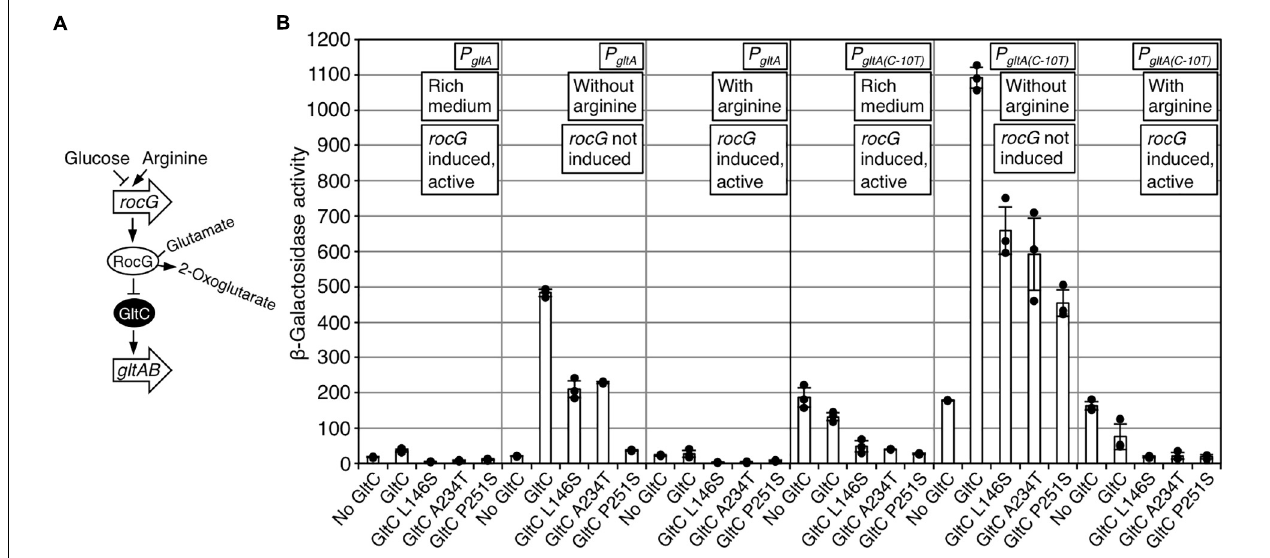
FIGURE 6 | (A) Control of DNA-binding activity of GltC by RocG. (B) Regulation of the P gltA wild type and the P gltA ( C − 10 T ) promoter in the strains GP650 ( P gltA -lacZ gltC − rocG + gudB − ) and GP692 ( P gltA ( C − 10 T ) -lacZ gltC − rocG + gudB − ), respectively, synthesizing the GltC variants L146S, A234T, and P251S variants with enhanced repressor function during growth in SP rich medium, CSE-Glc minimal medium without and with arginine. Isogenic strains carrying the plasmids pBQ200 (empty plasmid) and pGP907 (GltC) served as controls. Arginine was added to a final concentration of 0.5% (w/v). Data points represent biologically independent replicates. Bars indicate means of replicates and the standard deviations are shown. β -Galactosidase activities are given as units per milligram of protein. The plasmids carrying the gltC alleles are listed in Table 2